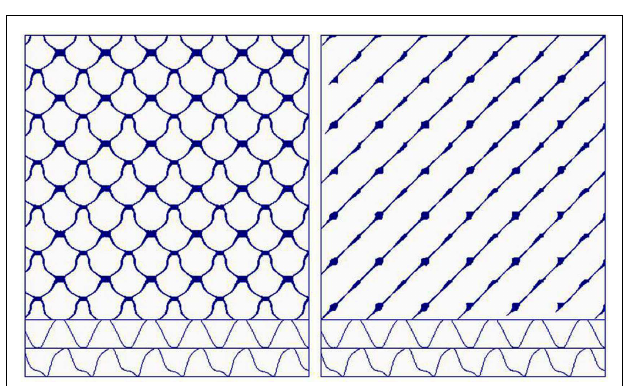
line structures, the length, number, positioning, etc. which convey